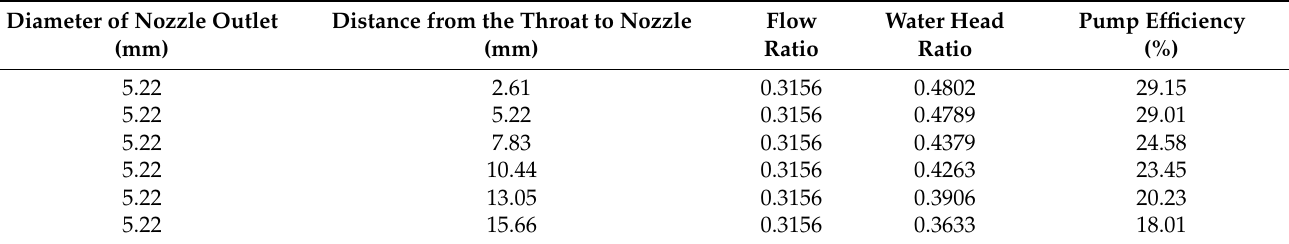
Table 4. Effect of different throat–nozzle distances on pump